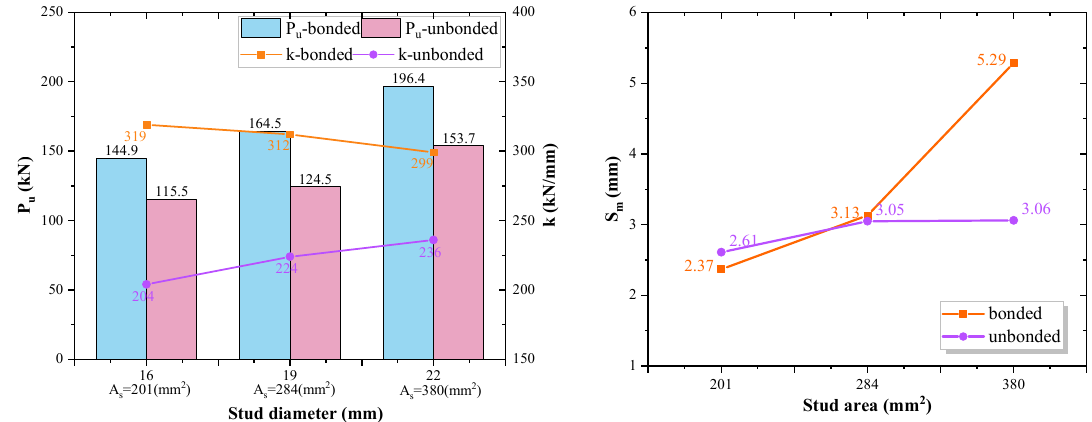
Figure 19. Influence of stud diameter on yield strength, shear stiffness and